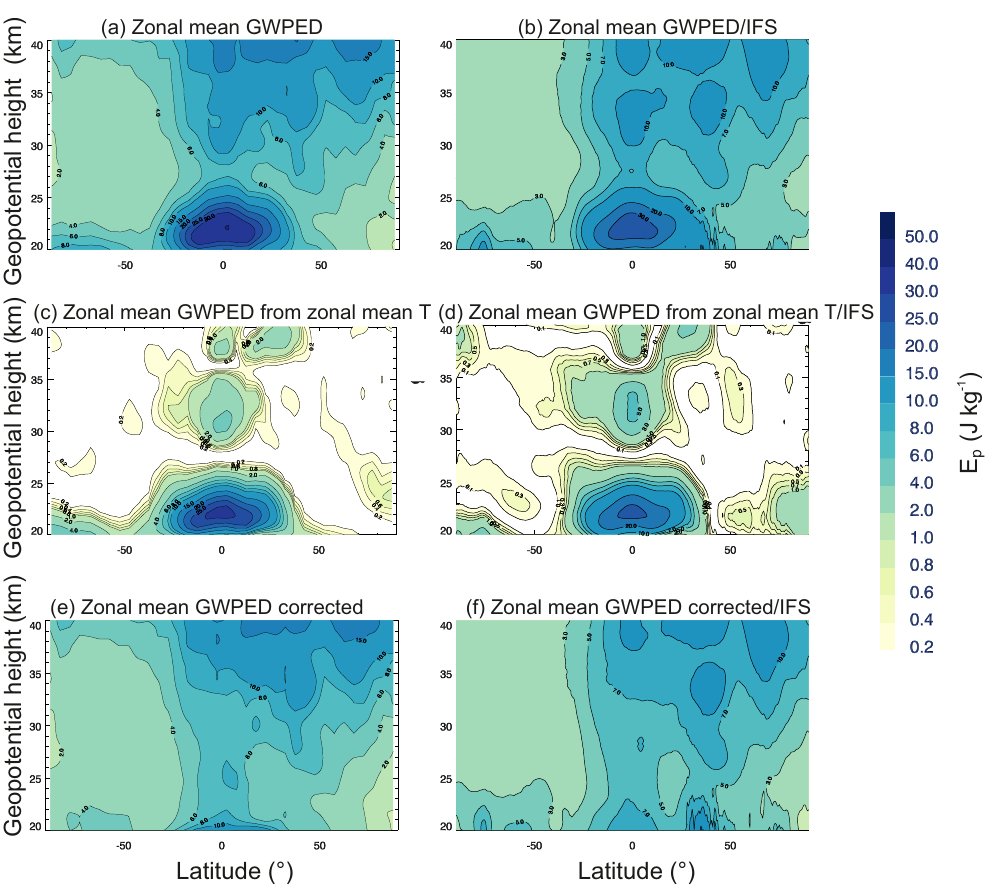
Figure 14. (a, b) : Monthly mean zonal mean distributions of E P as a function of latitude and altitude for December 2015 based on RO-dry data (a) and IFS data (b) . (c, d) Zonal mean apparent E P values derived from applying the E P algorithm to monthly mean zonal mean temperature profiles. (e, f) Difference between (a, b) and (c, d)